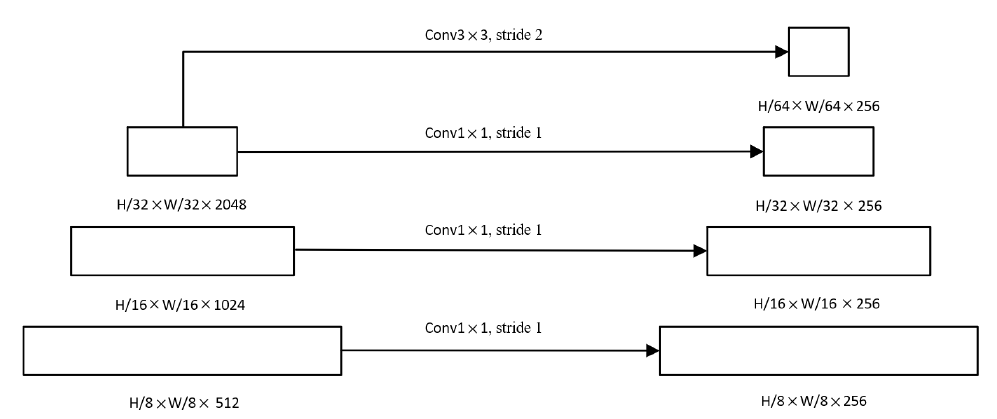
Figure 4. Multi-scale feature maps for Deformable Transformer